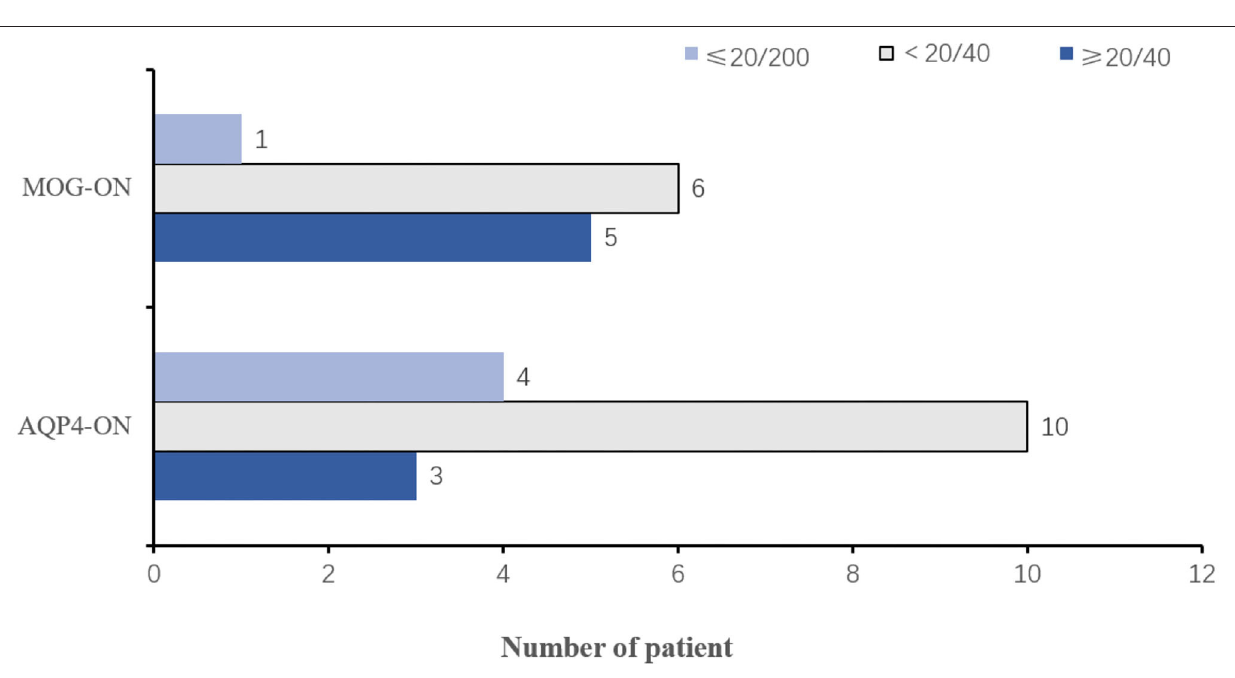
FIGURE 4 | Visual outcomes in MOG-ON and AQP4-ON patients. Histogram of the number of patients with MOG-ON and AQP4-ON in the VA ≤ 20/200 (superior, light blue), VA < 20/40 (middle, light gray), and VA ≥ 20/40 (inferior, dark blue) intervals; VA, visual acuity; MOG-ON, optic neuritis patients with MOG antibody; AQP4-ON, NMOSD patients with AQP4 antibody positive and a history of ON; OR, optic